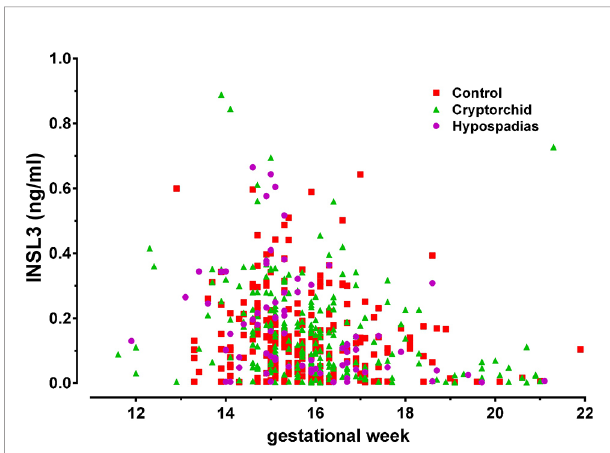
FIGURE 3 | INSL3 concentration measured by speci fi c time-resolved fl uorescent immunoassay from human amniotic fl uid samples collected at routine amniocentesis at the times indicated. The pregnancies were identi fi ed postnatally as normal (control), cryptorchid, or hypospadias [reproduced from